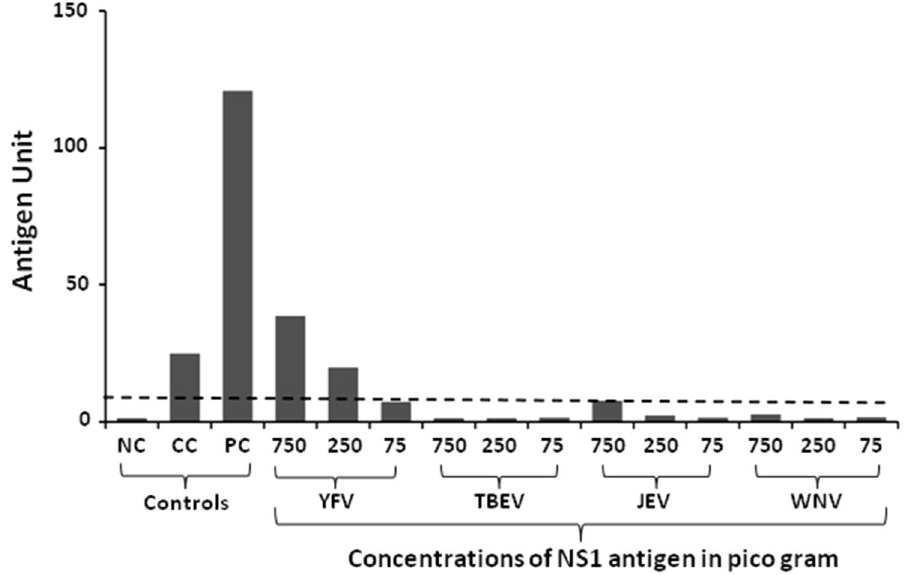
Figure 4. Detection of NS1 antigen of flaviviruses other than dengue serotypes. Recombinant Dengue NS1 antigen from the flaviviruses other than dengue was tested at different concentrations. YFV Yellow fever virus, TBEV Tick-borne encephalitis virus, JEV Japanese encephalitis virus, WNV West Nile virus, NC Negative control, CC Calibrator control, PC Positive control. Dotted horizontal line indicates the cut-off